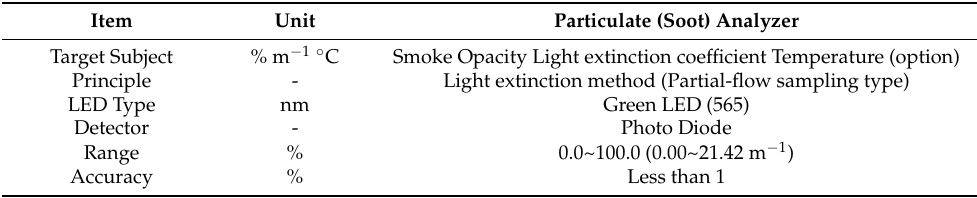
Table 2. Specification of OPA-102 for measuring diesel particulate(soot)